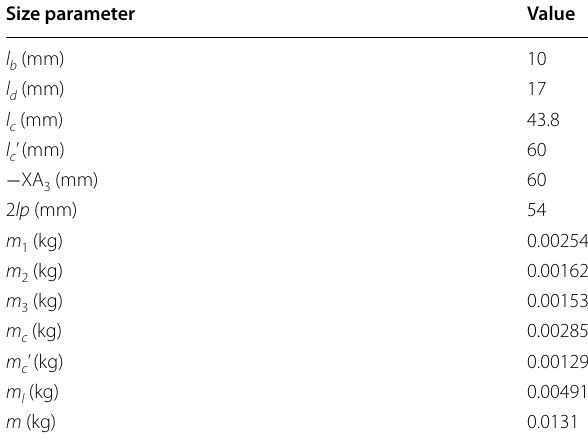
Table 1 Dimension Parameters of the 2T1R